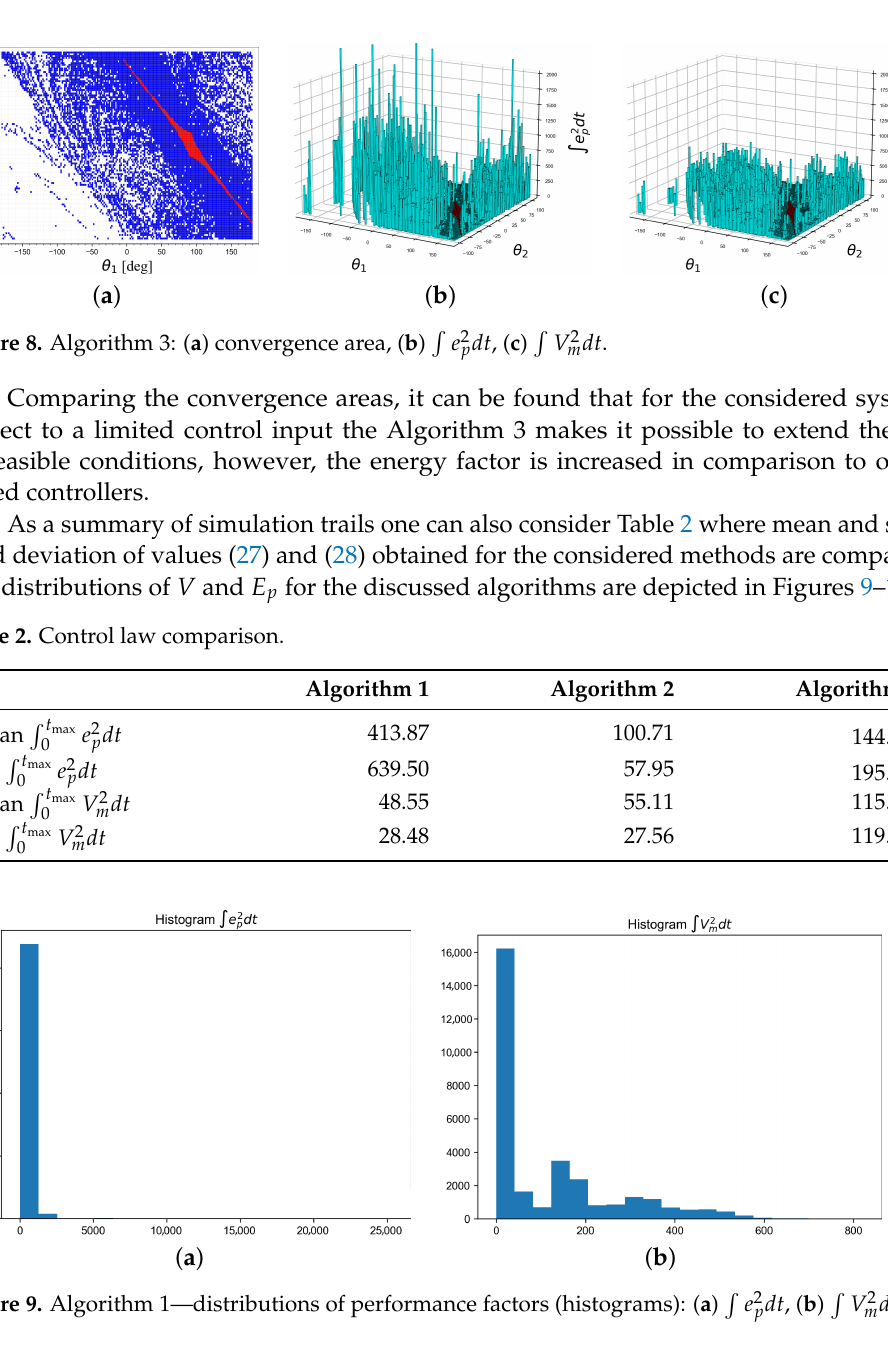
Figure 7. Algorithm 2: ( a ) convergence area, ( b )